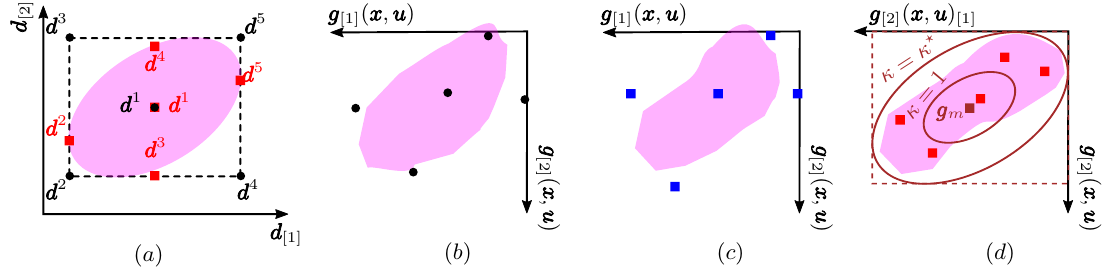
1 Figure 4. Comparison between multi-stage NMPC based on the vertex approximation, multi-stage NMPC based on the box over-approximation of the set of reachable states, multi-stage NMPC based on the box over-approximation of the reachable set of the constraint function. ( a ) Confidence region of the uncertain parameters. ( b ) Constraint space when the system is controlled using MS-VA